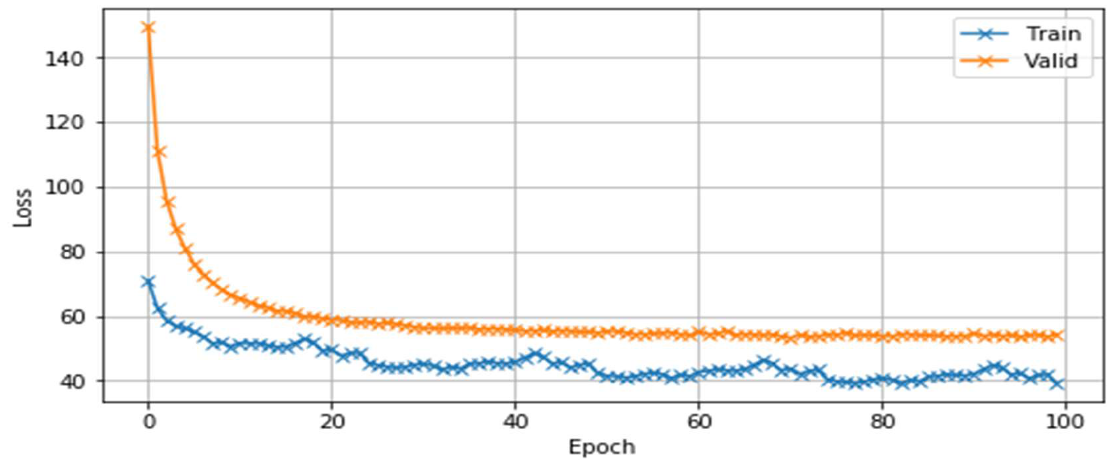
Figure 9. Change in loss error during learning steps sizes.